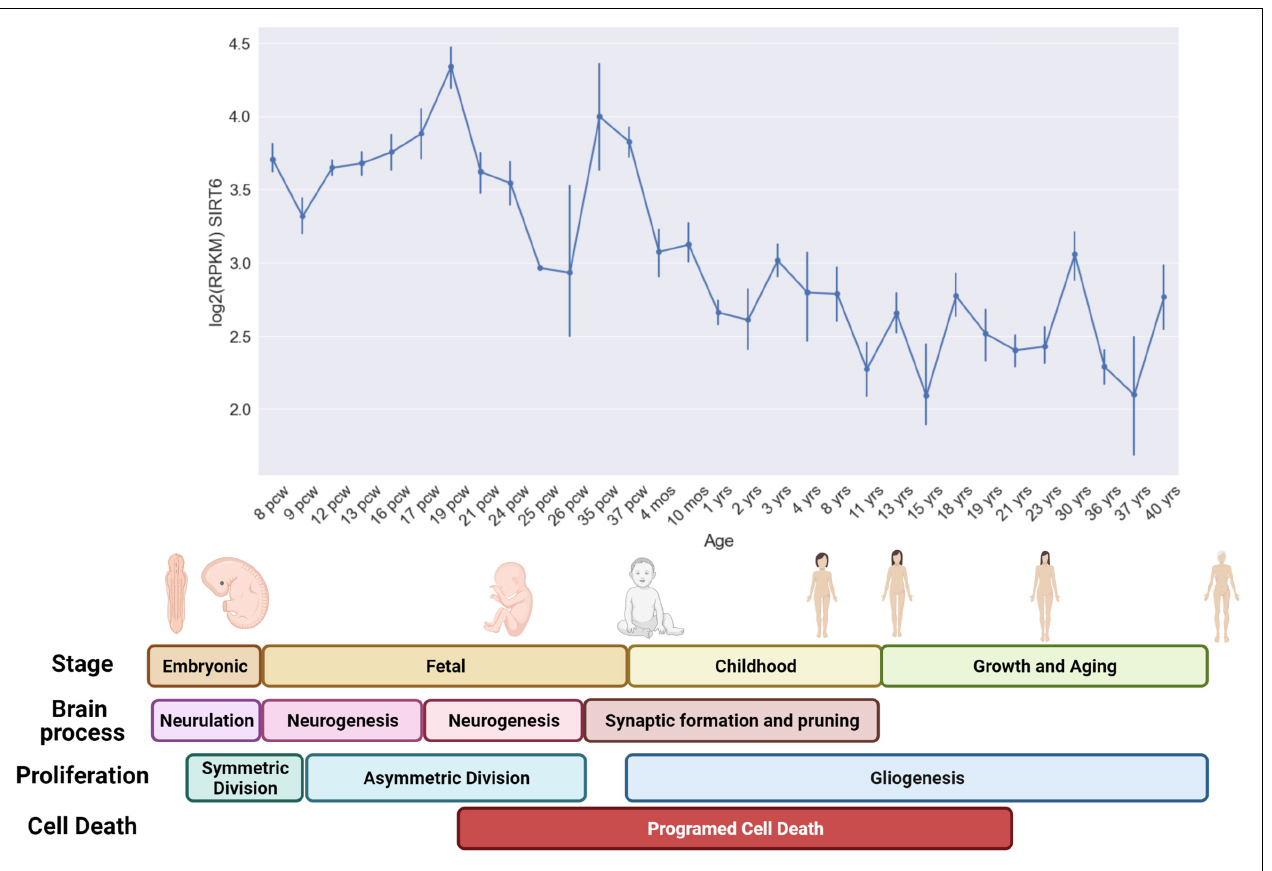
FIGURE 3 | Sirt6 expression during human development and life. In the upper graph, we show the mean expression level [Log2 (FPKM)] of several brain regions during specific developmental time points (Hawrylycz et al., 2012; Miller et al., 2014). The expression level was measured from post-conceptional week 8–9 (PCW) which correspond to the end of the embryonic stage and the start of the fetal stage (that last until birth). The formation of the primitive neural tube with the embryonic pouches that will give rise to the different CNS regions occurs during embryonic stages (Neurulation). At the beginning of the fetal period (6 pcw), the neural stem cells start to proliferate mainly through symmetric division that generates two NSCs. This symmetric division progressively switches toward an asymmetric division that generates a neural progenitor and a differentiated neuron, this shifting occurs approximately at 10 pcw and lasts until neurogenesis is completed at 27 pcw. Early during neurogenesis, the formation of synaptic connections occurs, and lasts until childhood, also programmed cell death is visible in neurogenic regions since the beginning of this process. However, programmed cell death occurs mainly in perinatal stages, and allows the survival of only those neurons that were capable to form stable and functional connections. Gliogenesis occurs mainly in postnatal periods. The expression of Sirt6 shows an increase that coincides with the proliferative burst of asymmetric division of neural progenitors and decreases toward the period when programmed cell death begins to clean those non-functional neurons (Stiles and Jernigan,